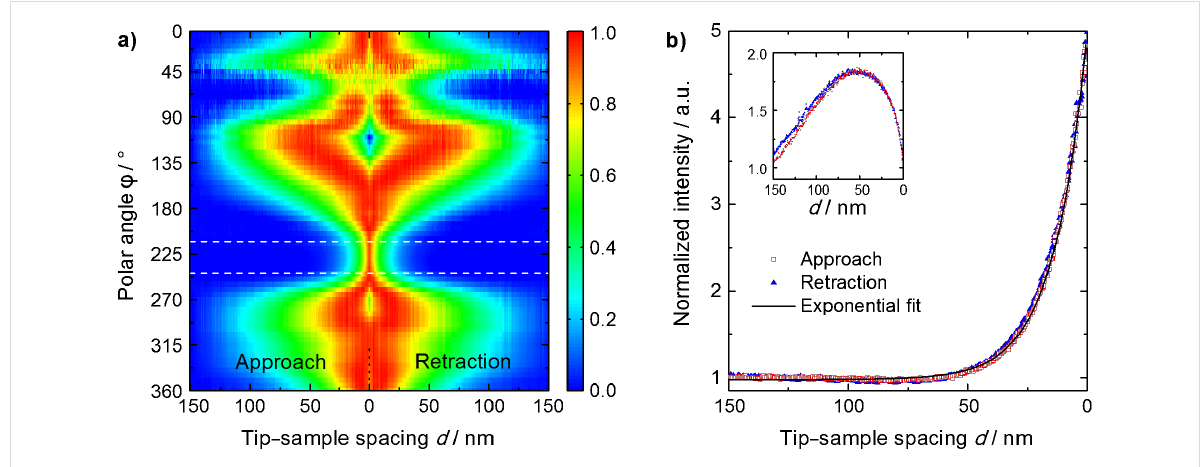
Figure 5: Quantitative analysis of the evolution of k-space patterns during tip approach and retraction. Panel a) shows the angular intensity distribu- tion, radially integrated across the ROI (cf. Figure 4a), as a function of tip–sample spacing. At each angle, the data have been normalized. The region between the two dashed white lines has been averaged with respect to the angle and the data have been plotted in panel b) together with an expo- nential fit to the part of the data recorded during approach. The decay length is 14 nm. Here, the data have been normalized to the background signal. The inset shows an equal set of data for a different angular region around